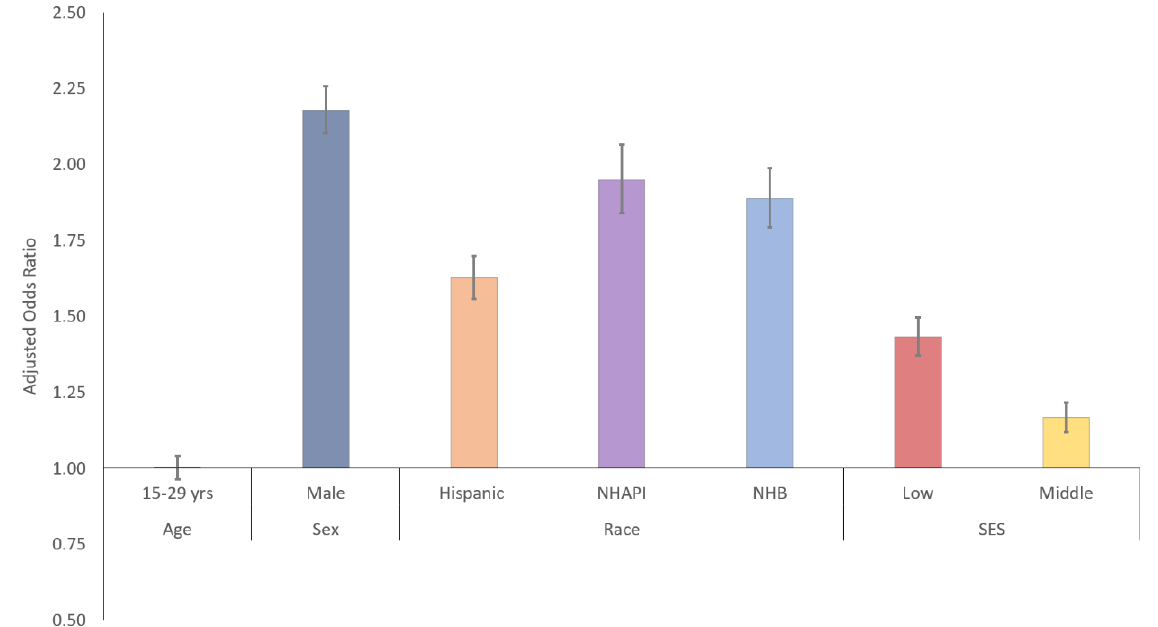
Figure 2. Risk of metastatic disease by sociodemographic subgroup for poor-prognosis cancers in aggregate . Table 2. Crude and Adjusted Odds Ratio for Metastatic Disease Presentation: Surveillance, Epide- miology, and End Results Program (2000–2016).